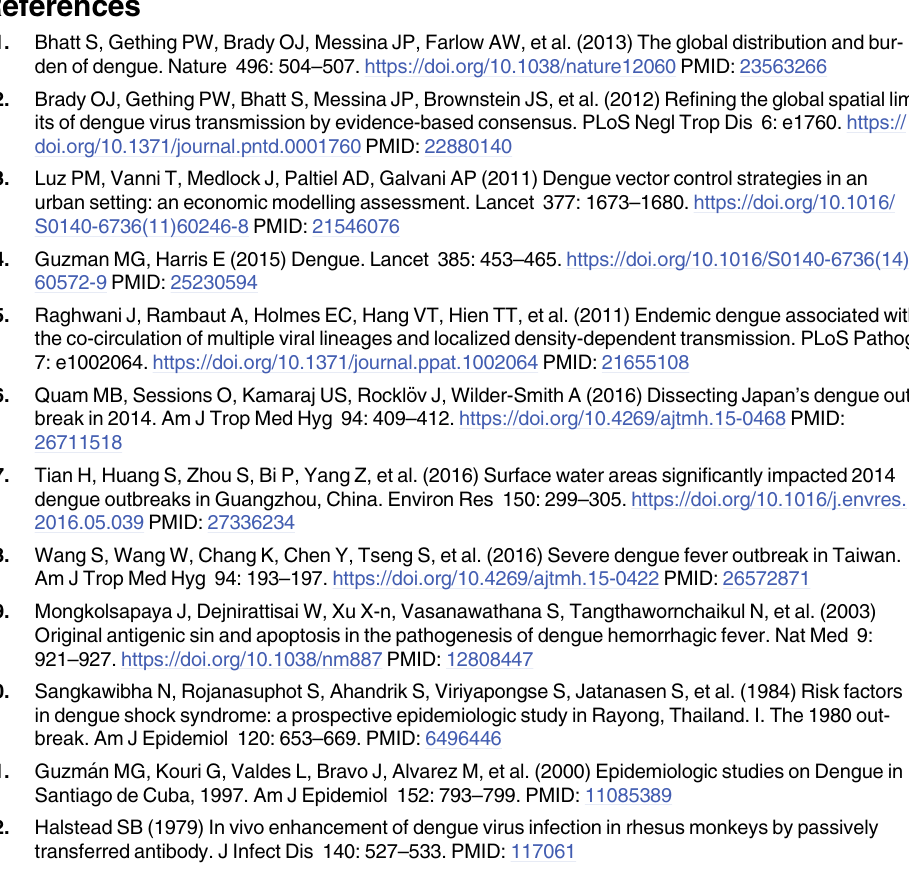
S1 Table. Subsampled DENV E gene sequences in study. S2 Table. Strongly supported DENV migrations estimated from E gene